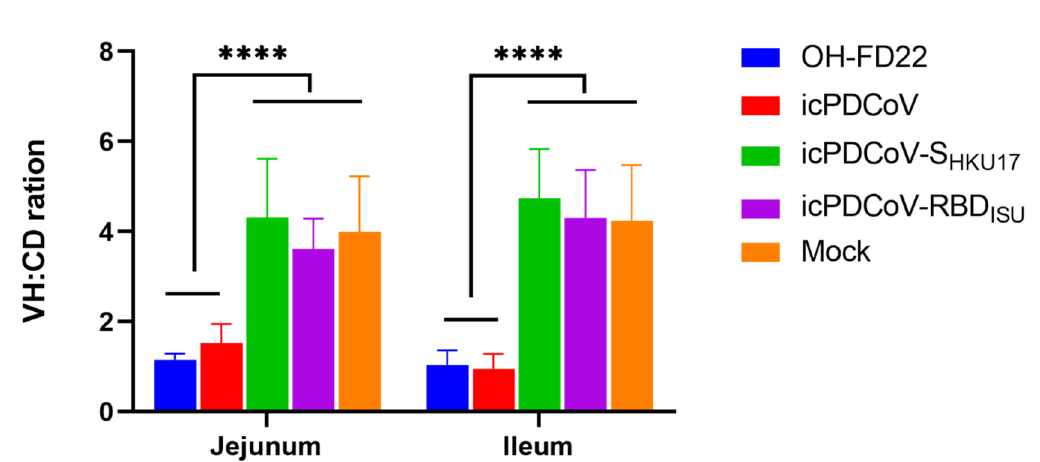
Figure 5. Villous height to crypt depth (VH:CD) ratios of piglets inoculated with recombinant viruses icPDCoV, icPDCoV- S HKU17 or icPDCoV-RBD ISU . OH-FD22 and mock groups were controls. Groups with significant differences (**** p < 0.0001) are indicated with different letters.